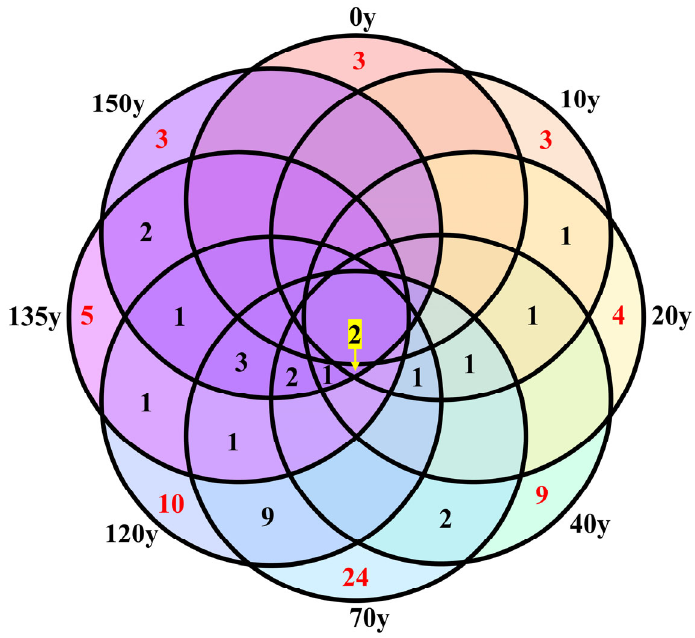
Figure 2. Venn diagram of the different stages of vegetation restoration. Each circle represents a collection of species at one stage. The numbers outside the circles are the corresponding vegetation restoration periods (in years). The red font inside the circles indicates the total number of endemic plants at each stage (T ‐ SS). Endemic plants occur in one stage only. The black numbers in the circles indicate the plants common to the corresponding stages.